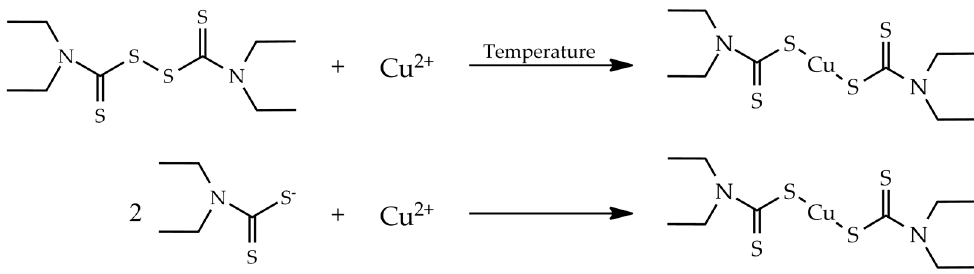
Figure 1. Synthesis of copper (II) diethyldithiocarbamate.